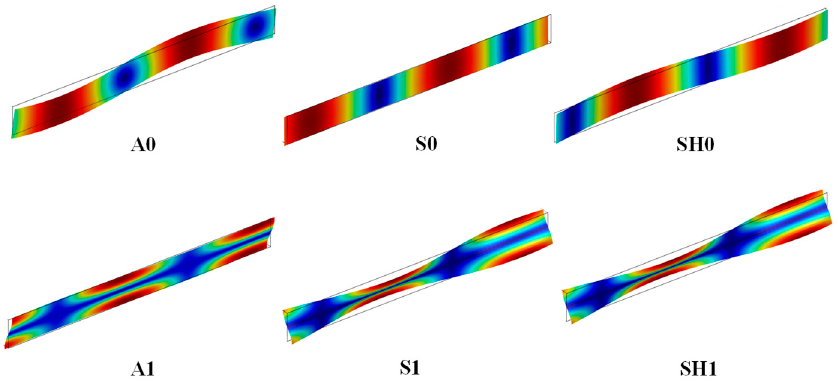
Figure 1. Schematic of the mode shapes of the first six plate modes (Lamb modes: A 0 , S 0 , A 1 , S 1 , and SH plate modes: SH 0 and SH 1 ) propagating in the Z-cut LiNbO 3 membrane when h LiNbO3 / λ = 0.1.